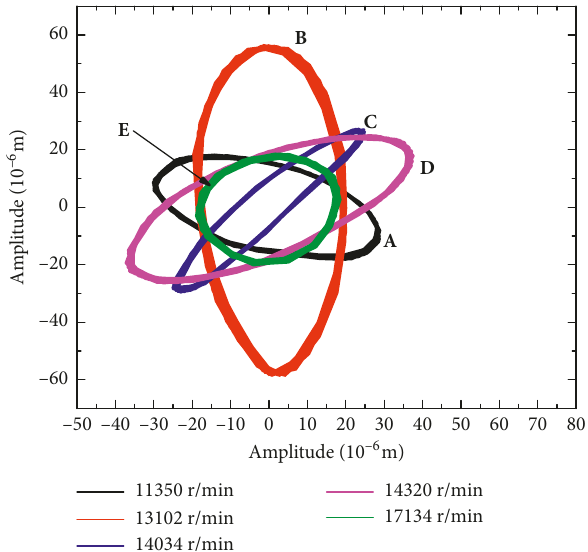
Figure 18: Axis orbits at five moments during the conical whirling critical speed